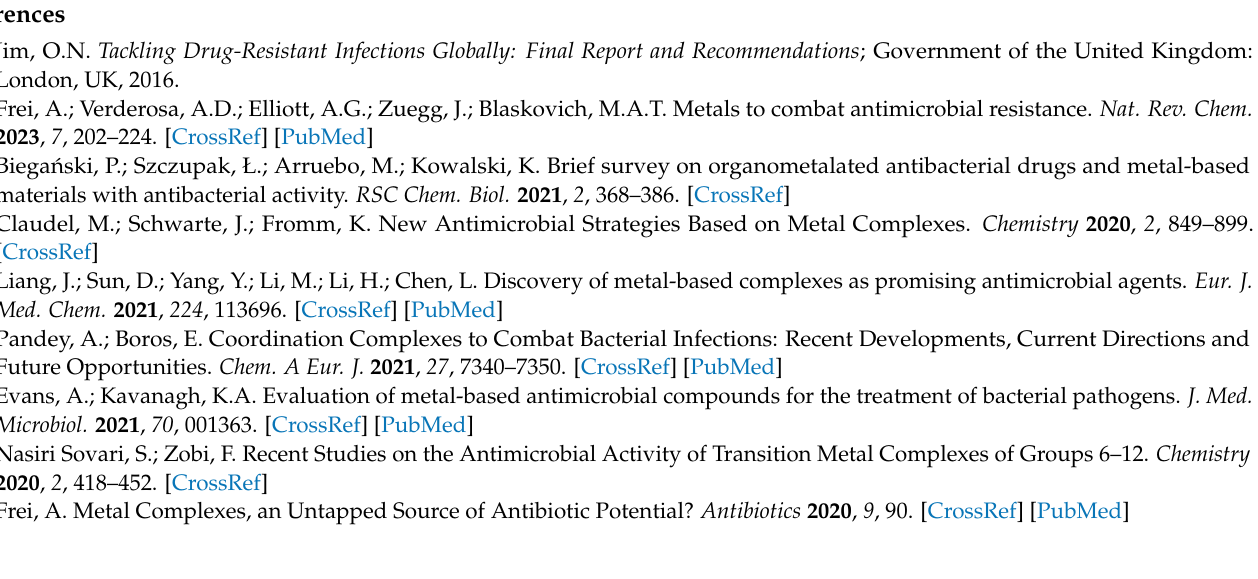
in CD 3 CN, aromatic region; Figure S3: 1 H NMR spectrum of a 2a/2b 3:1 mixture in CD 3 CN, aliphatic region; Figure S4: 1 H NMR spectrum of a 3a/3b 4:1 mixture in CD 3 CN, (cid:81) = solvent residual peak; Figure S5: 1 H NMR spectrum of a 3a/3b 4:1 mixture in CD 3 CN, aromatic region; Figure S6: 1 H NMR spectrum of a 3a/3b 4:1 mixture in CD 3 CN, aliphatic region; Figure S7: 1 H NMR spectrum of 4 in CD 3 CN; Figure S8: 1 H NMR spectrum of 4 in CD 3 CN, aromatic region; Figure S9: 1 H NMR spectrum of 4 in CD 3 CN, aliphatic region; Figure S10: 1 H NMR spectrum of 5 in CD 3 CN; Figure S11: 1 H NMR spectrum of 5 in CD 3 CN, aromatic region; Figure S12: 1 H NMR spectrum of 5 in CD 3 CN, aliphatic region; Figure S13. IR spectrum of a 2a / 2b 3:1 mixture (left) and of a 3a / 3b 4:1 mixture; Figure S14. IR spectrum of 4 (left) and 5 ; Figure S15. UV-Vis spectrum of a 2a / 2b 3:1 mixture (left) and of a 3a / 3b 4:1 mixture in MeOH; Figure S16. UV-Vis spectrum of 4 (left) and of 5 in MeOH; Figure S17. Weak interaction between one of the ctz phenyl rings and one of the aromatic rings of the bpy ligand in the structures of 1 (left) and corresponding Mn complex; Figure S18. Homological model Residues in the pocket; Figure S19. Surrounding amino acids histogram for Drug 1 and 2D distribution bonds in two planes (YZ and XY) for the H-bonds from the center of the ligand; Figure S21. Surrounding amino acids histogram for Drug 2a and H-bonds distribution maps in two planes (ZY and XY); Figure S22. Surrounding amino acids histogram for Drug 2b and H-bonds distribution map in plane YZ; Figure S23. Surrounding amino acids histogram for Drug 3a and H-bonds distribution map map for plane YZ; Figure S24. Surrounding amino acids histogram for Drug 3b and H-bonds distribution map in plane YZ; Figure S25. Surrounding amino acids histogram for Drug 3b and H-bonds distribution map for plane YZ; Table S1. Prescreening AutoDock molecular docking results for different homological MurG models (fixed receptor) with inhibitors 1 – 5